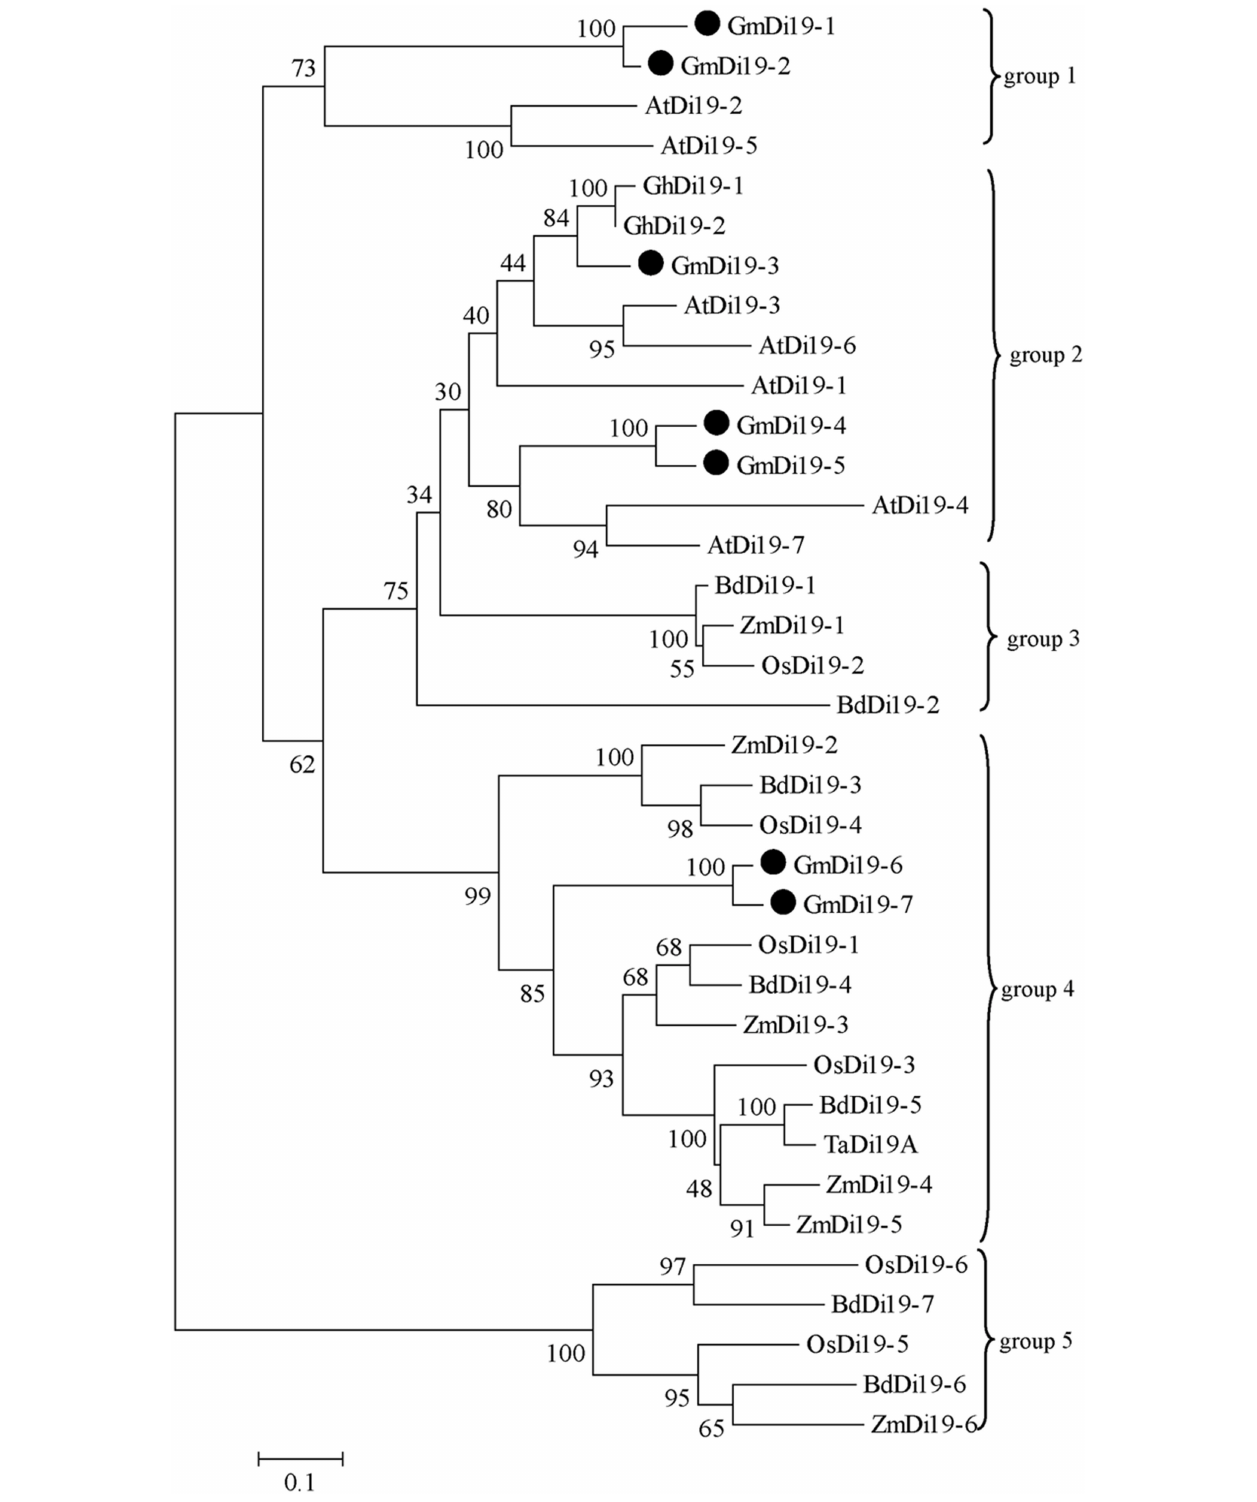
FIGURE 2 | Phylogenetic relationship of the soybean Di19s with those of Arabidopsis , rice, maize, Brachypodium , cotton, and wheat.